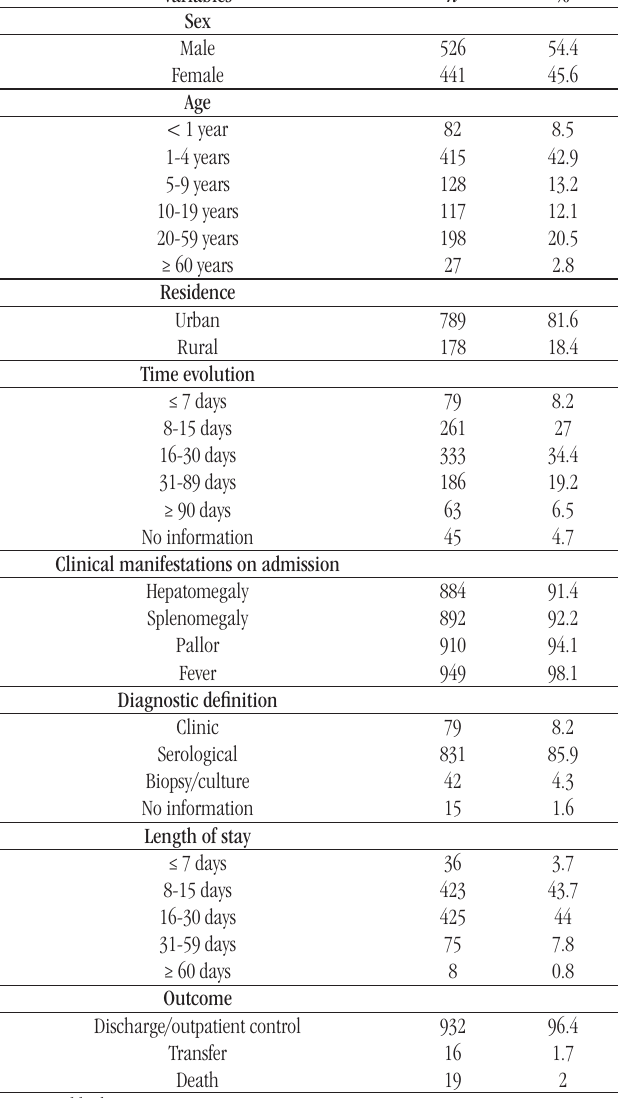
TABLE 1 – Demographic, clinical, and evolution data of hospitalized patients with a diagnosis of VL at the Hospital Universitário Clemente Faria, Montes Claros, Minas Gerais, Brazil, in the period